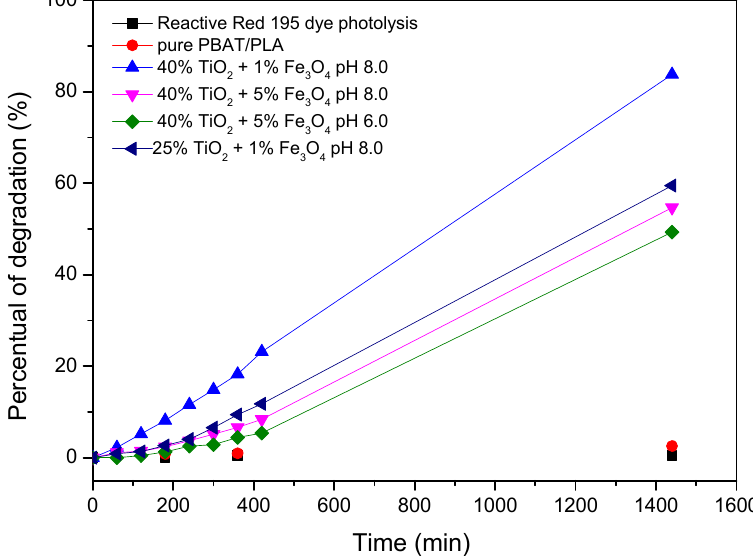
Figure 1. Degradation of BF-4B Reactive Red dye (35 mg L − 1 ) for polymeric fibers of pure PBAT/PLA; incorporated and the photolysis of the dye at pH 7 under luminous intensity of 46 W m 2 .